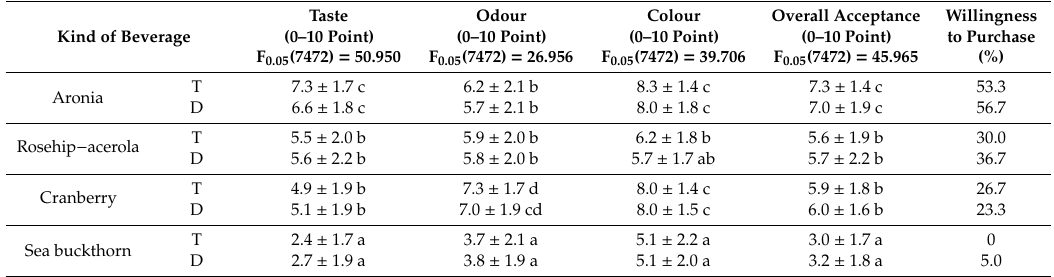
Table 4. Consumer acceptance of fruit-herbal beverages and willingness to